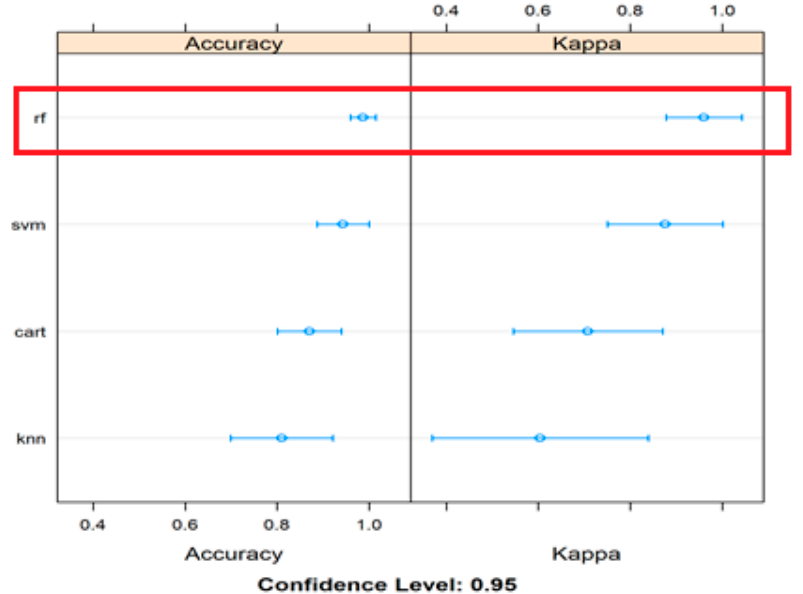
Figure 5. Comparison of different machine learning algorithms; rf—Random Forest, svm—Support Vector Machine, cart—classification and regression trees, knn—k-nearest neighbour. The Random Forest algorithm obtained the best results with a mean accuracy of 98.67% and κ of 96.00%. Therefore, the Random Forest algorithm was selected for further analysis (Table 3). Table 3. Results of accuracy and kappa values for algorithms: cart, knn, svm, rf.